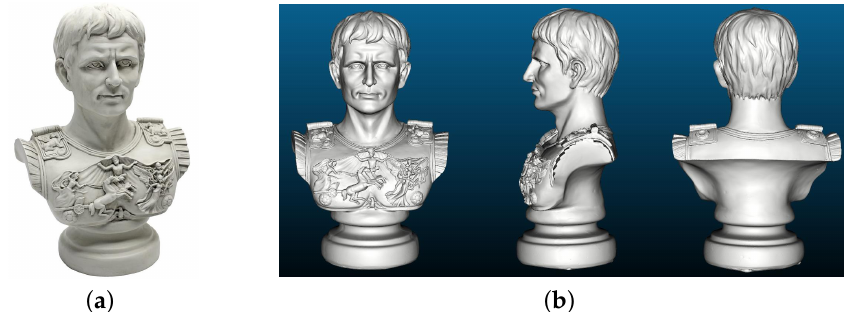
Figure 12. The Caesar sculpture ( a ) and its ground truth model ( b ). This sculpture is made of synthetic resin with a dimension of 16.5 × 26.7 × 45.7 cm, and the ground truth (reference) model is obtained using a fringe projection based industrial 3D scanner